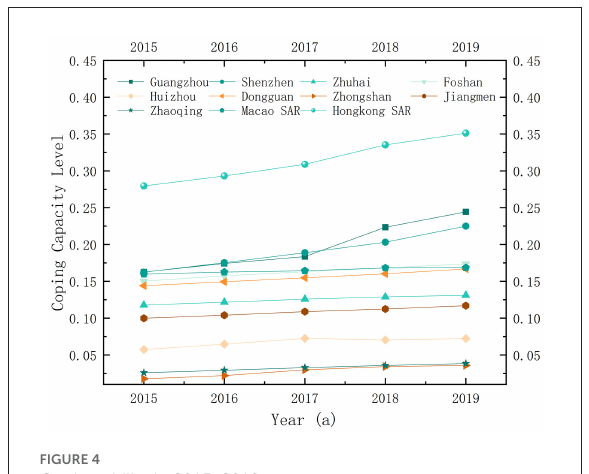
FIGURE5 Spatial pattern of coping